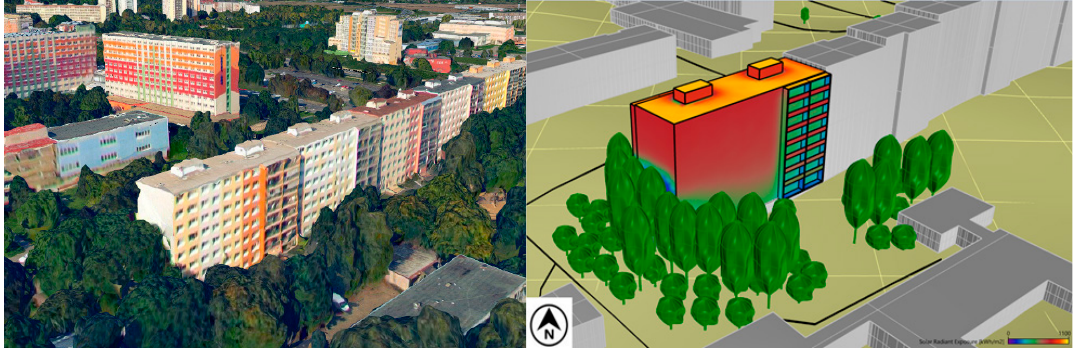
Figure 6. Location ( left ) and annual solar irradiation map ( right ) of the case study building.